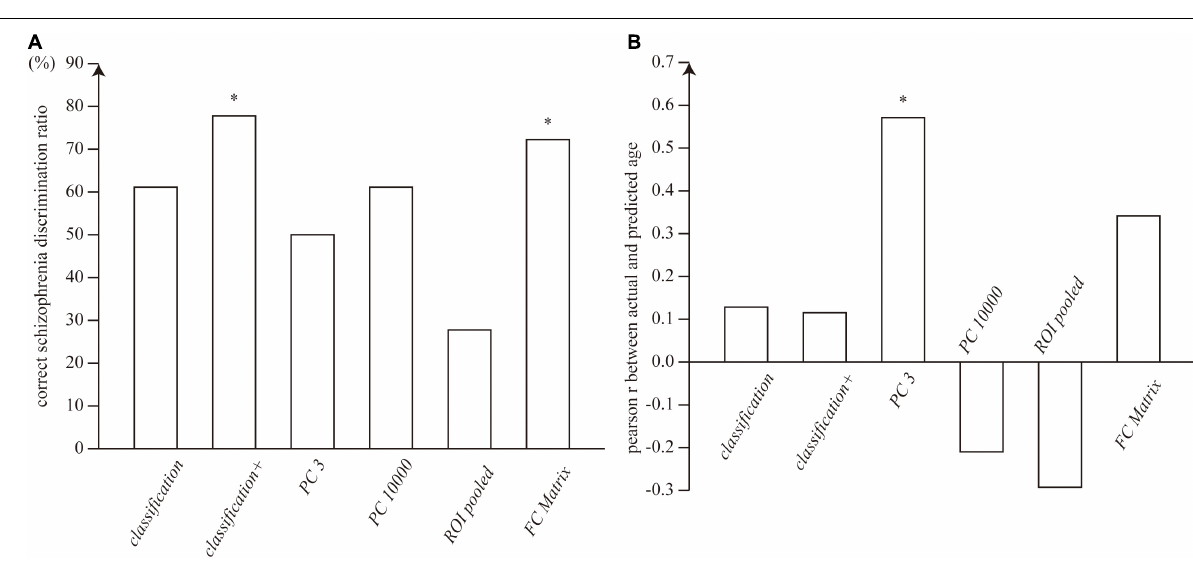
FIGURE 3 | (A) Accuracy of the schizophrenia discrimination. (B) Pearson’s correlation coefficient of the age regression. The single asterisks show the statistical significance at α =